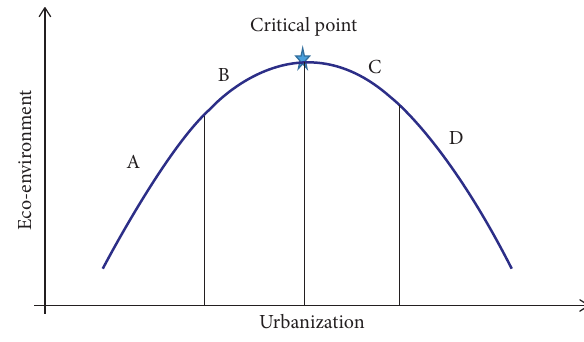
Figure 3: The environmental Kuznets curve